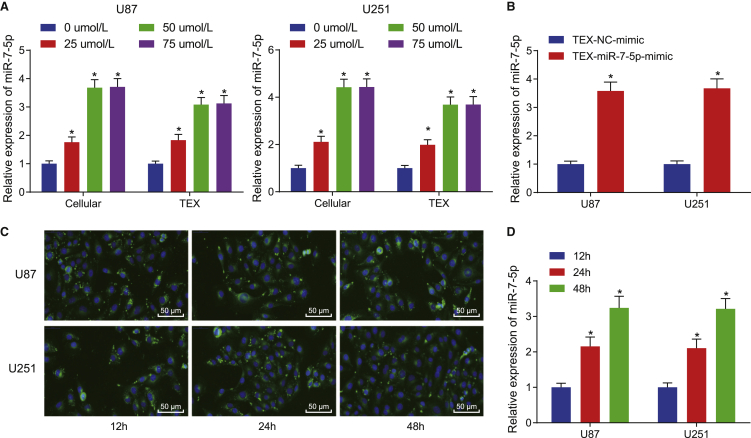
VB promotes the expression of miR-7-5p in GBM and boosts its transfer by exosomes to recipient GBM cells(A) The expression of miR-7-5p in the cell and in the supernatant TEXs from the GBM cells treated with VB at different concentrations (0, 25, 50, and 75 μΜ) for 48 h was detected by qRT-PCR. (B) The expression of miR-7-5p in purified TEXs from miR-7-5p-mimic-transfected U87 and U251 cells was detected by qRT-PCR. (C) The uptake of exosomes by GBM cells was observed under a fluorescence microscope after tracing with CFSE (×200). (D) The expression of miR-7-5p was detected by qRT-PCR in U87 and U251 cells at 12, 24, and 48 h. Data were shown as mean ± standard deviation of three technical replicates. One-way ANOVA was used for data comparison in (A) and (D) with Tukey’s post-test test. Unpaired t test was used for data comparison in (B). ∗p < 0.05, ∗∗p < 0.01, compared with 0 μΜ group, TEX-NC-mimic group, or 12 h group.